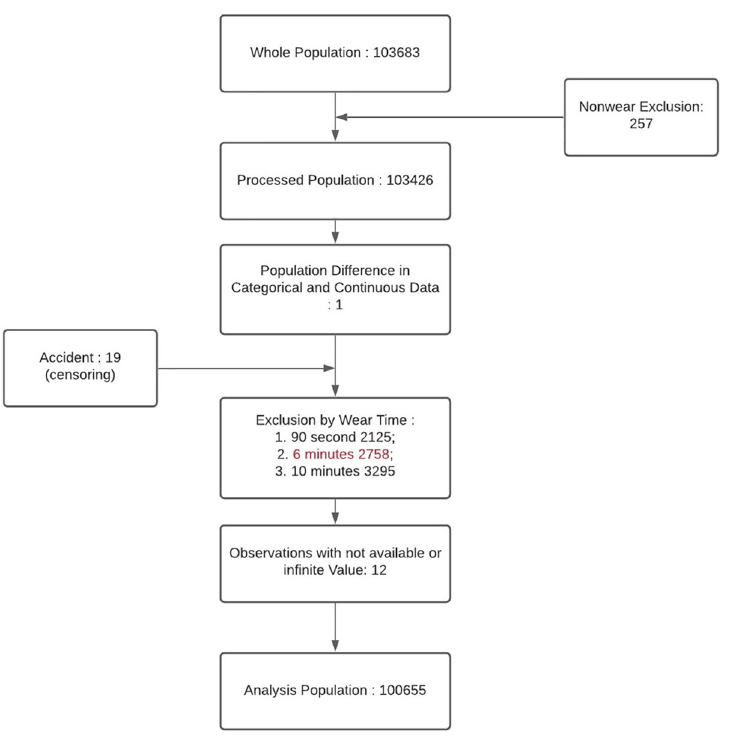
Fig 2. Participant flowchart. Inclusion/Exclusion for Mortality